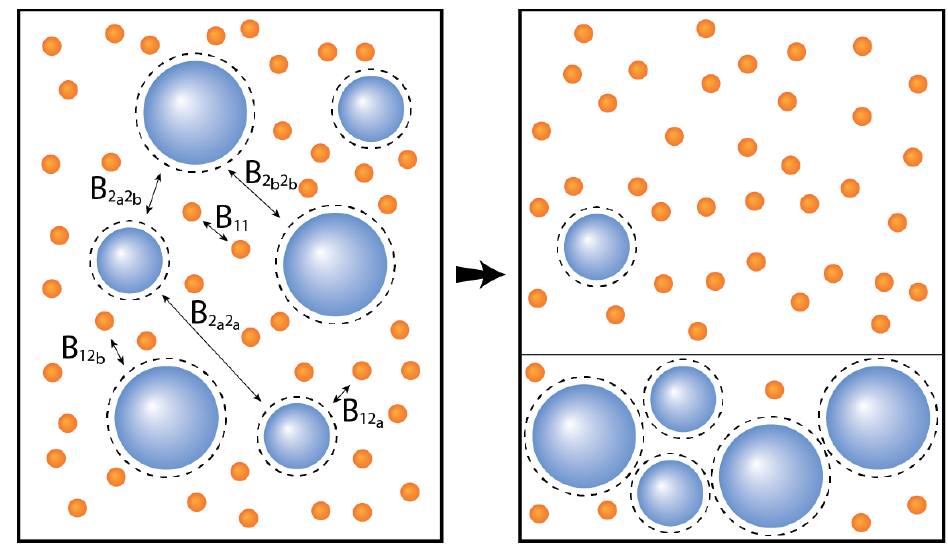
Figure 1. Graphical representation of a simple polydisperse mixture, in which the polydisperse component consists of two sub-components ( a and b , n = 3), second virial coefficients are indicated. The mixture demixes into two phases: one phase enriched in the small component and one phase enriched in the large polydipserse